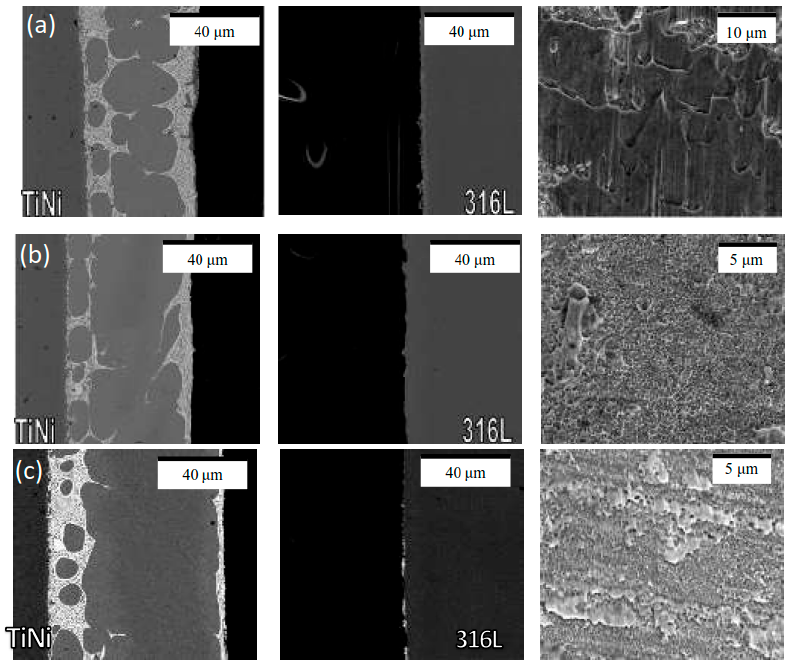
Figure 8. SEM BEI cross-sections and SEI fractographs of Ti 50 Ni 50 /Cusil-ABA/Cu foil/BAg-8/316L SS joint infrared brazed at 850 °C for 300 s after shear test with the Cu interlayer of ( a ) 25; ( b ) 50; and ( c ) 70 µ m in thickness. (TiNi: Ti 50 Ni 50 substrate, 316L: 316L SS